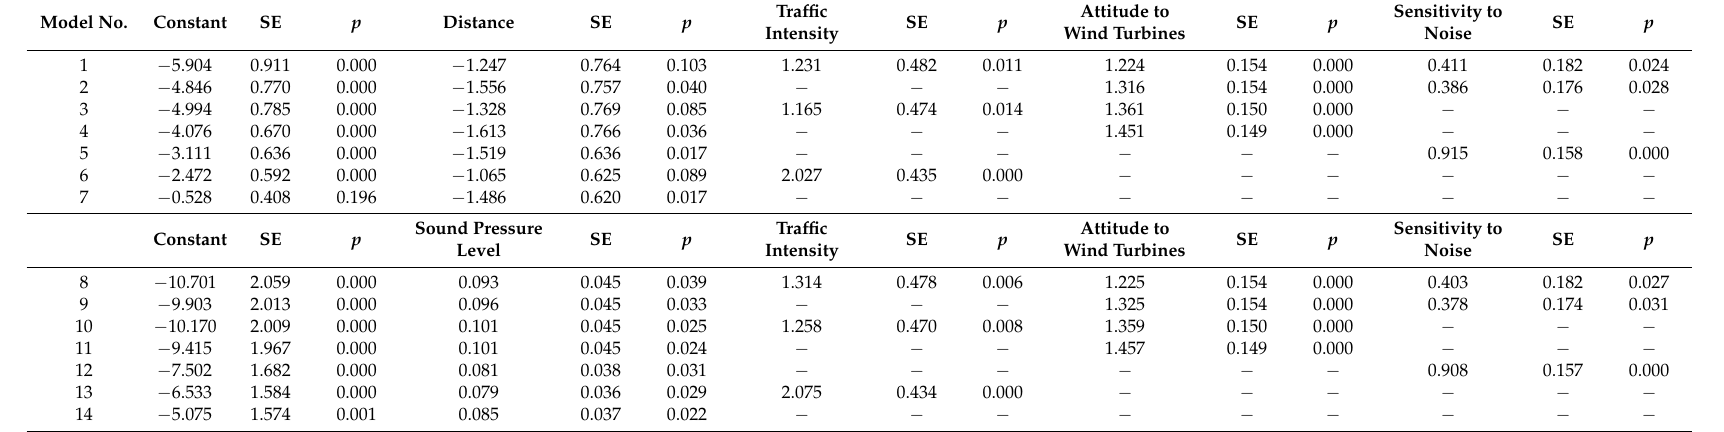
Table 13. Estimated coefficients for various logistic models of high annoyance due to the wind turbine noise